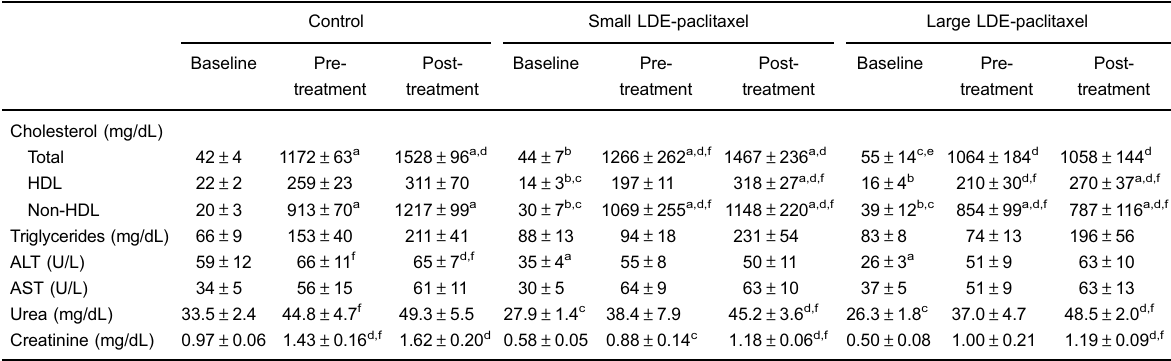
Table 1. Biochemical analysis of rabbits from control group (n=9) and treated with small lipid nanoparticles (LDE)-paclitaxel (n=10) and large LDE-paclitaxel (n=9). Control Small LDE-paclitaxel Large LDE-paclitaxel Baseline Pre- Post- Baseline Pre- Post- Baseline Pre- treatment treatment treatment treatment treatment